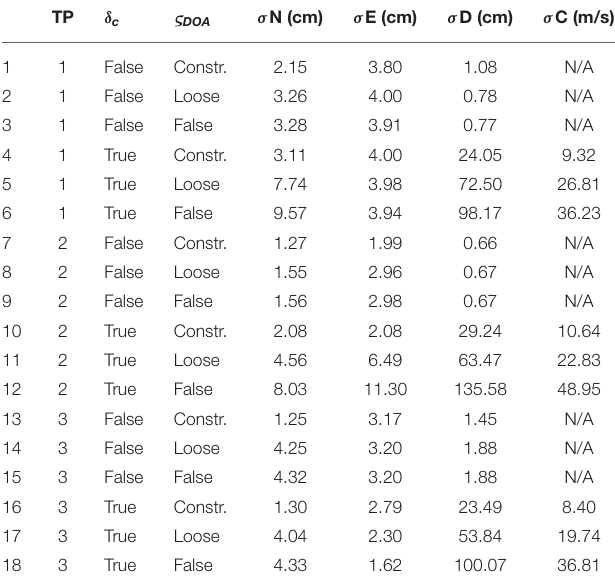
TABLE 3 | Standard deviations of the North, East, Depth, and Celerity components, for each parameterizations ( δ c and ς DOA columns) and each transponders (TP column) in box-in